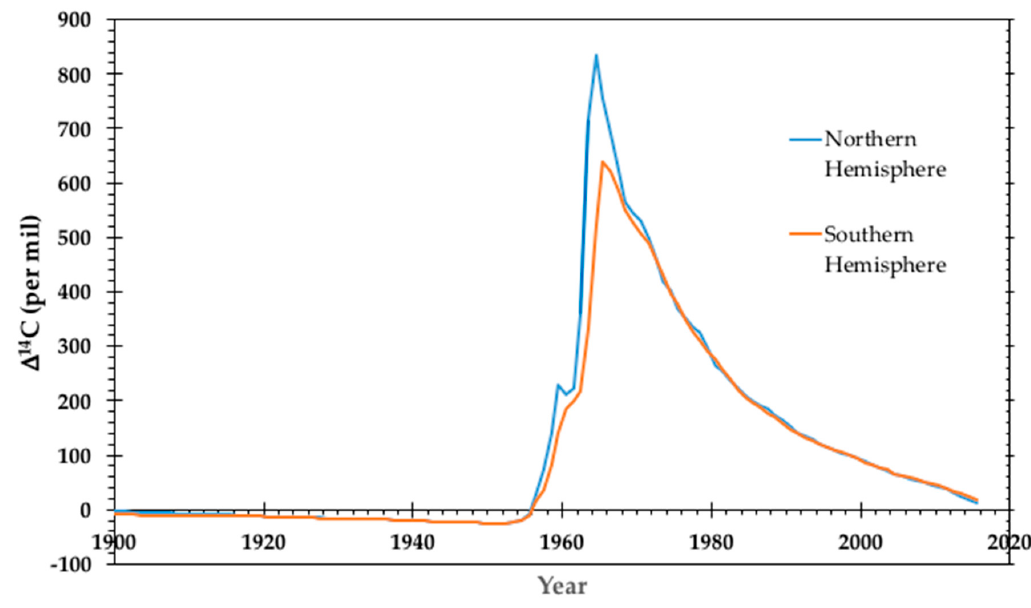
Figure 4 . Annual averages of atmospheric 14 C/C for the northern and southern hemispheres. Data before 1959 is derived from plant material while data from 1959 to present is derived from atmospheric CO 2 collections and plant material. Data is reported in the Δ 14 C convention described by Stuiver and Polach [38].